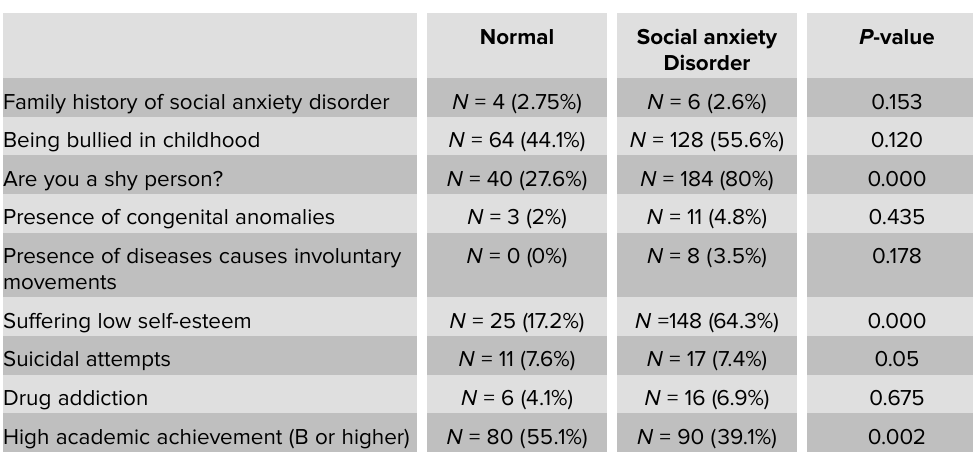
TABLE 3: Poisson regression analysis of associated factors of